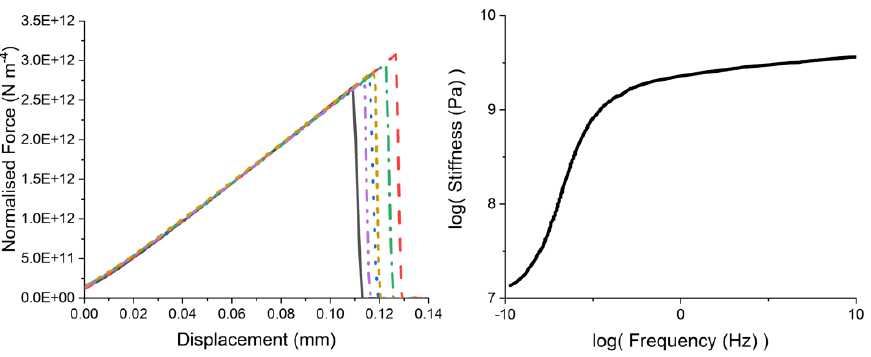
Fig. 2 . Normalised Force vs displacement for ceramic specimens in bending. The force was normalised by the second moment of area of each specimen.